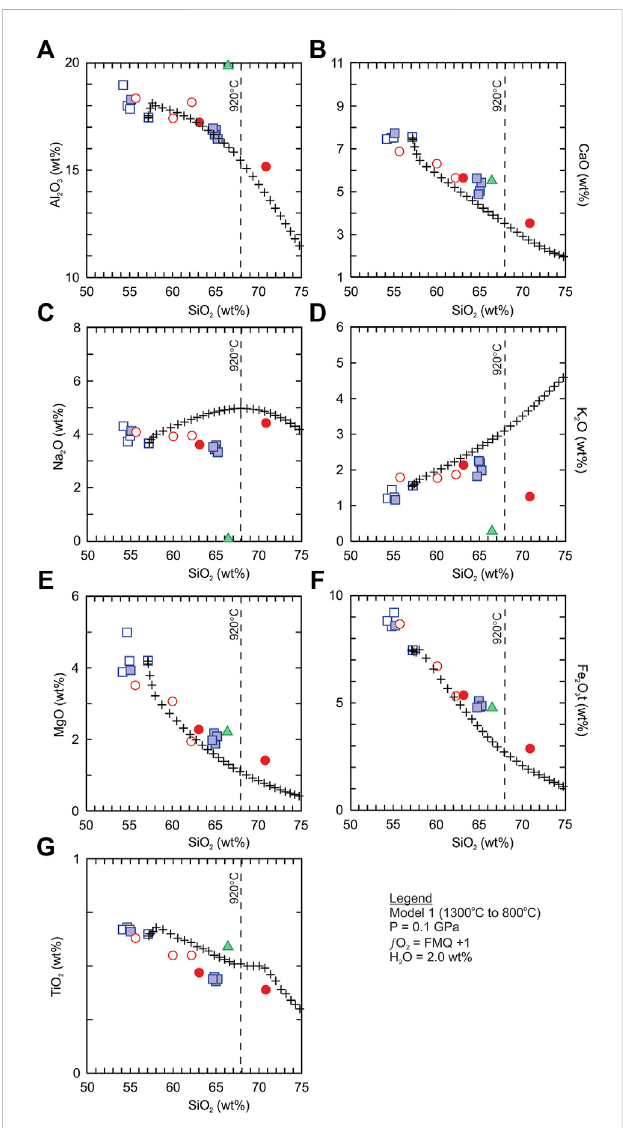
FIGURE 12 The results of hydrous fractional crystallization of the Snoul pluton at 0.1 GPa and f O 2 = Δ FMQ +1. (A) Al 2 O 3 (wt%), (B) CaO (wt%), (C) Na 2 O (wt%), (D) K 2 O (wt%), (E) MgO (wt%), (F) Fe 2 O 3 t (wt%), and (G) TiO 2 (wt%) vs. SiO 2 (wt%). The residual silicic liquids compositions are at 10 ° C intervals. The complete modeling results are in online Supplementary Table S6. All data are normalized to 100%. Symbols of the Snoul pluton are the same as in Figure